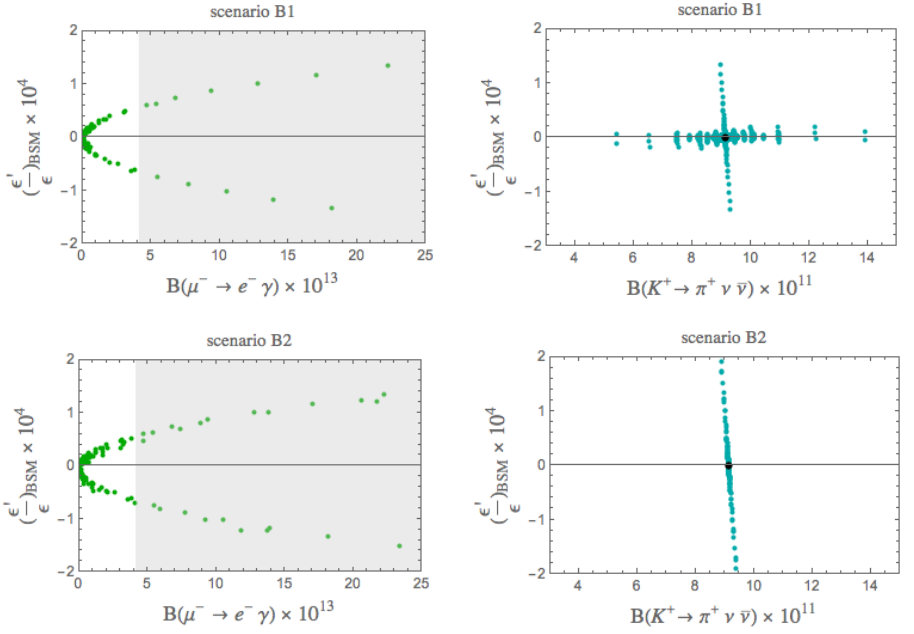
Figure 12 . Scenarios B1 (upper plots) and B2 (lower plots). Correlations involving the ( " 0 =" ) (the NP contribution to " 0 =" ). Correlation with B ( (cid:22) (cid:0) ! e (cid:0) (cid:13) ) (left panels) and with B ( K + ! (cid:25) + (cid:23) (cid:22) (cid:23) ) (right panels). The gray shaded region is excluded by the experimental bound B ( (cid:22) (cid:0) ! e (cid:0) (cid:13) ) < 4 : 2 (cid:1) 10 (cid:0) 13